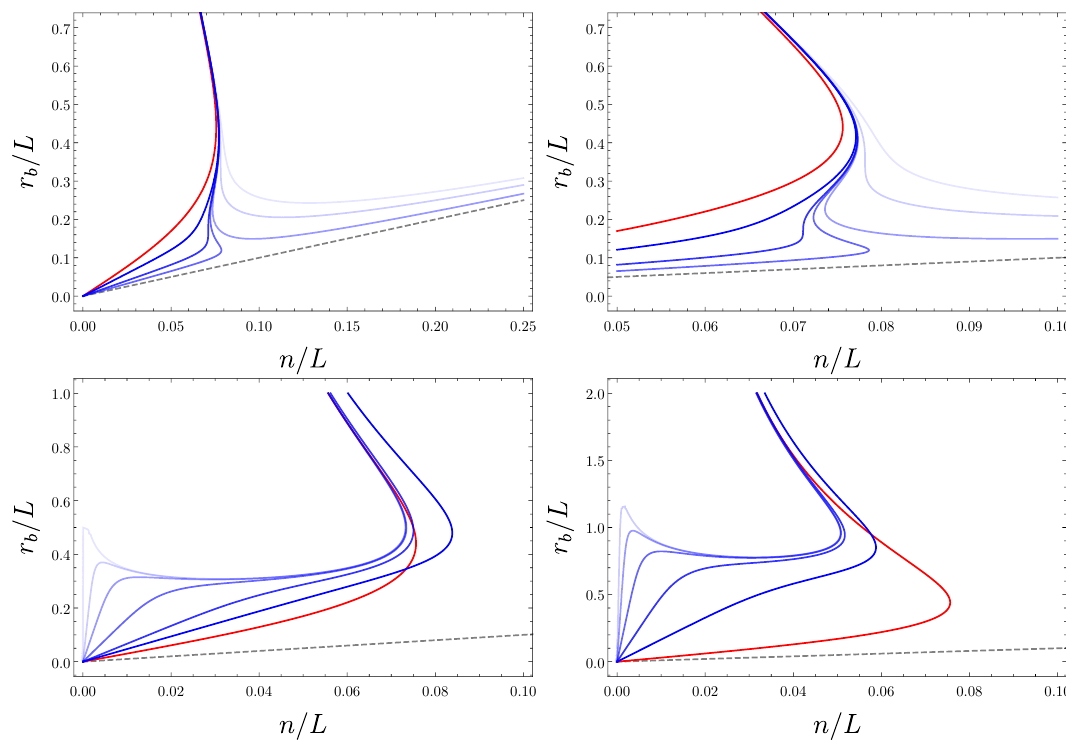
Figure 12 . Top row: plots of r b vs. n for (cid:12)xed (cid:24) = (cid:0) 4 (cid:2) 10 (cid:0) 5 with (cid:16) (cid:2) 10 5 = (cid:0) 20 ; (cid:0) 23 : 15 ; (cid:0) 23 : 8 ; (cid:0) 25 ; (cid:0) 38 : 03 ; (cid:0) 70 (more to less opacity, or left to right for any horizontal slice through the plot). The right plot is a zoomed in version of the left, showing the interesting struc- ture for bolt solutions. Bottom row: plots of r b vs. n for positive (cid:16) . The left plot shows curves for (cid:16) = 10 (cid:0) 3 with (cid:24) = (cid:0) 10 (cid:0) 3 ; (cid:0) 10 (cid:0) 4 ; (cid:0) 10 (cid:0) 5 ; (cid:0) 10 (cid:0) 6 ; (cid:0) 10 (cid:0) 7 ; (cid:0) 10 (cid:0) 10 (in order of decreasing opacity in the plot, or right to left along a horizontal slice through the plot). The right plot shows, for the same values of (cid:24) , the result when (cid:16) = 27 = 256 (cid:0) (cid:24) , which corresponds to the critical limit. The behaviour when (cid:16) > 0 is all qualitatively similar. In all plots, the red curve represents the Einstein gravity result, and the dashed, gray line represents the limiting circumstance of r b = n